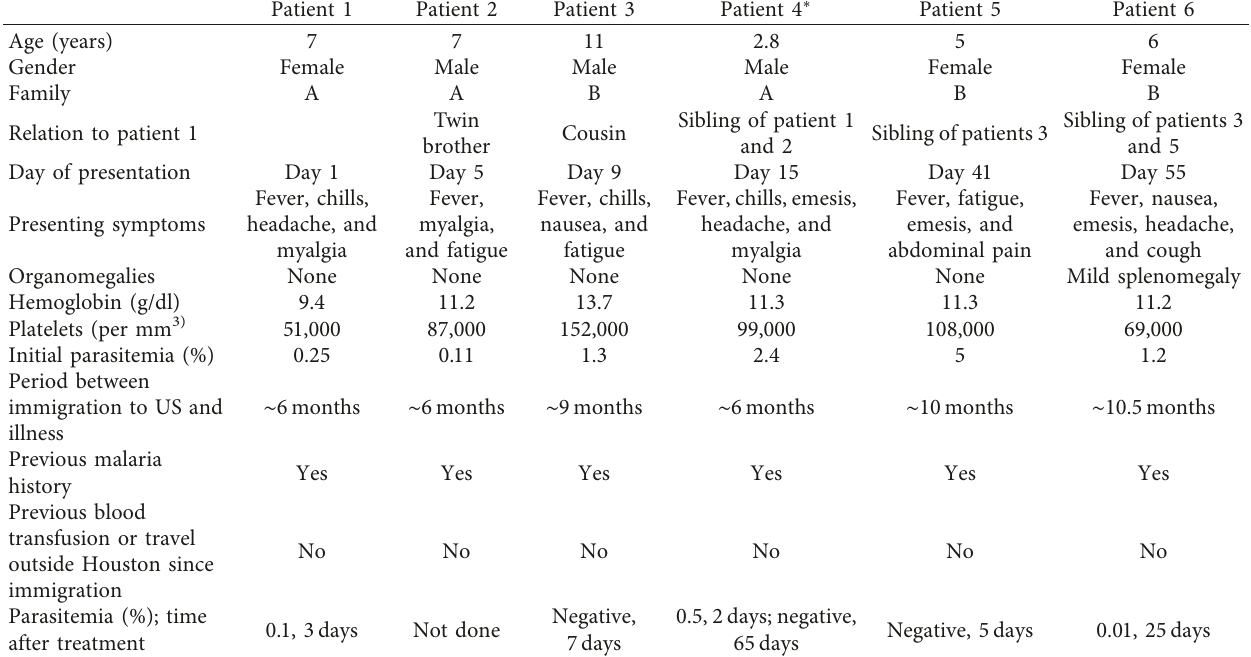
Table 1: Clinical and laboratory characteristics of the